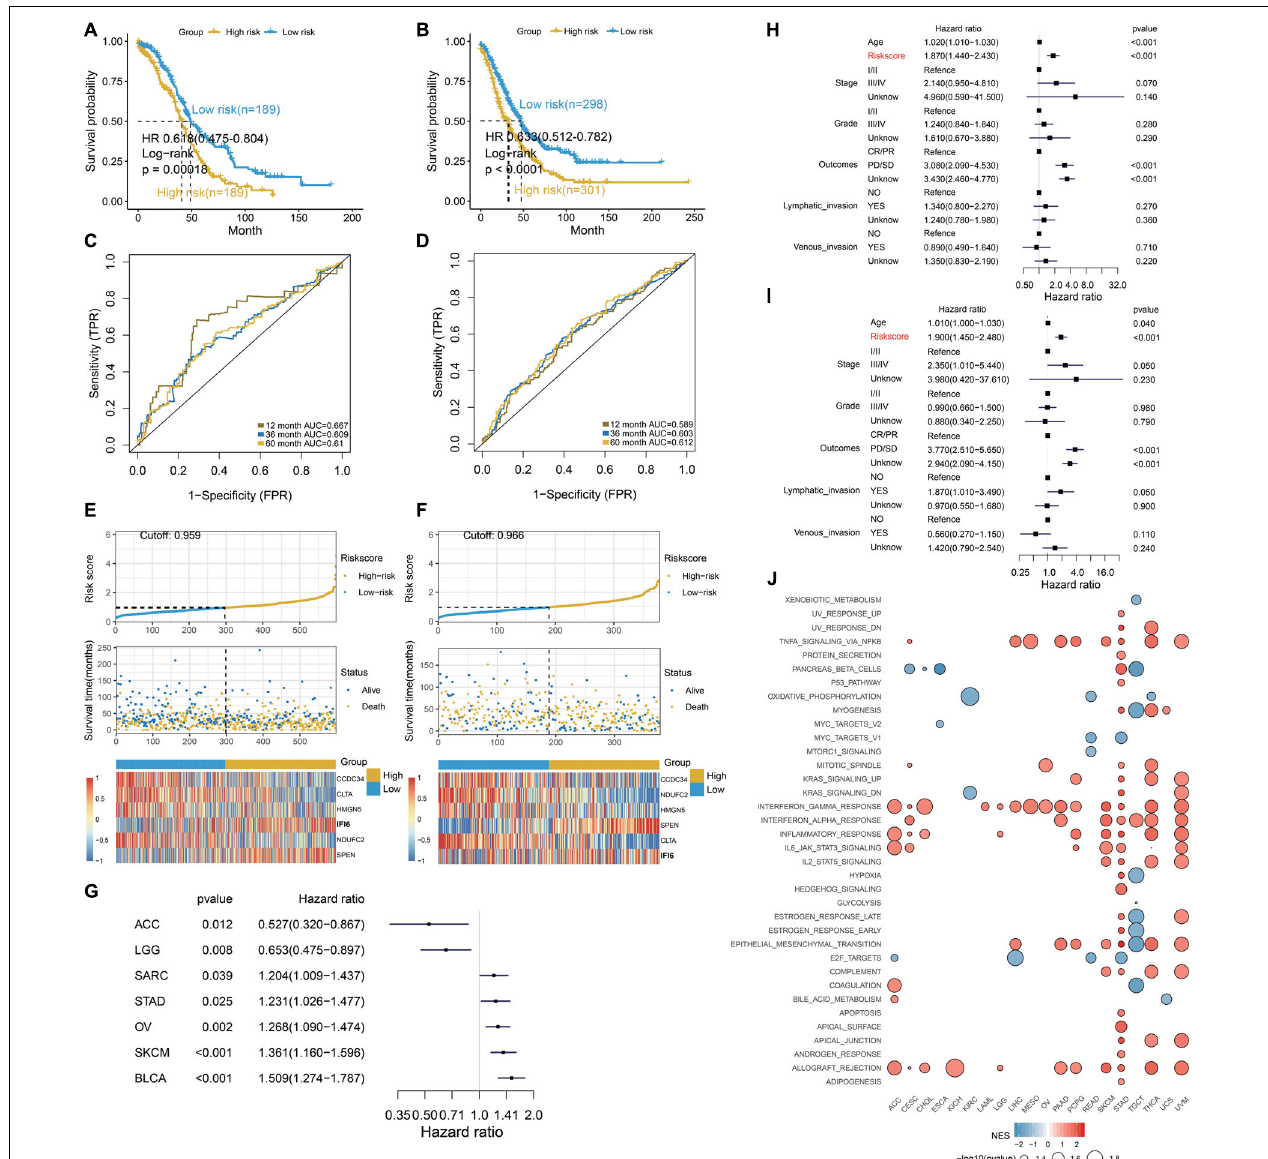
FIGURE 7 | Excellent prognosis of the RiskScore. (A,B) Kaplan–Meier survival curves, (C,D) time-dependent ROC curve analyses, (E,F) RiskScore distribution, survival status, and gene expression profile for patients in high- and low-RiskScore groups in the TCGA OC cohort and GEO OC dataset. (G) Forest plot illustrating the OS of the RiskScore in multiple cancers. SARC, sarcoma; STAD, stomach cancer; OV, ovarian cancer; SKCM, Melanoma; BLCA, bladder cancer; ACC, adrenocortical cancer; LGG, lower grade glioma. (H,I) RiskScore is determined to be an independent and robust prognostic factor for OC samples by univariate Cox regression (H) and multivariable Cox regression (I) analysis. (J) Dot plot showing the functions of RiskScore across multiple